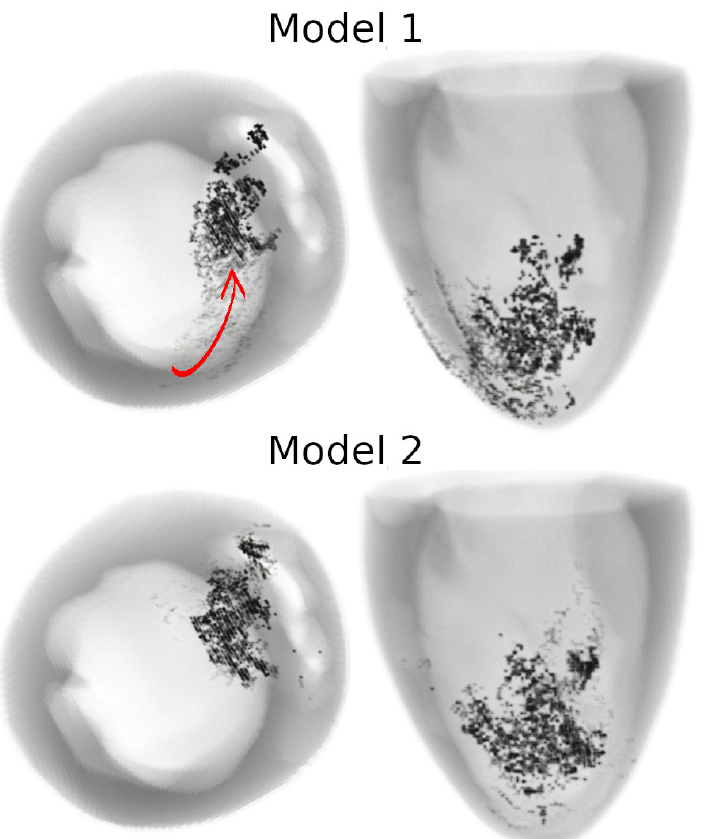
Figure A5. Trajectory of the spiral wave tip on the epicardial and endocardial surfaces in normal rat heart simulations. Time is indicated by color: the darker the point, the further it is from the beginning of the simulation. The arrow is drawn along the spiral drift path for Model